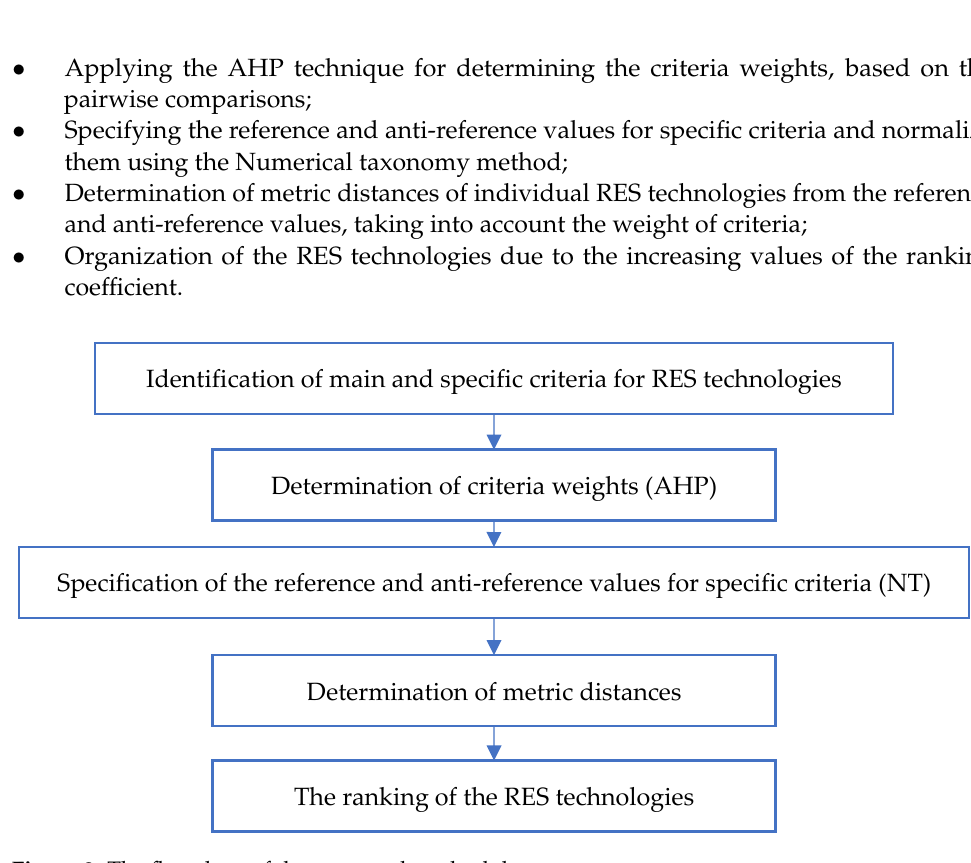
Figure 2. The flowchart of the proposed methodology.